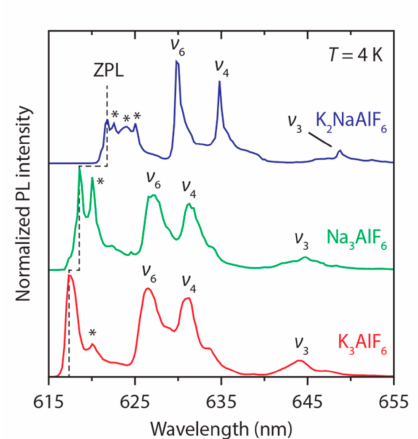
Figure 4. Emission spectra of K 3 AlF 6 :Mn 4+ (1.2%) (red), Na 3 AlF 6 :Mn 4+ (0.4%) (green) and K 2 NaAlF 6 :Mn 4+ (0.9%) (blue) at T = 4 K. The excitation wavelength is 460 nm. Labels are assigned to the highest-energy zero-phonon line (ZPL) and vibronic 2 E → 4 A 2 emissions ( ν 3 , ν 4 and ν 6 ). The stars mark lines assigned to ZPLs of other Mn 4+ sites (see